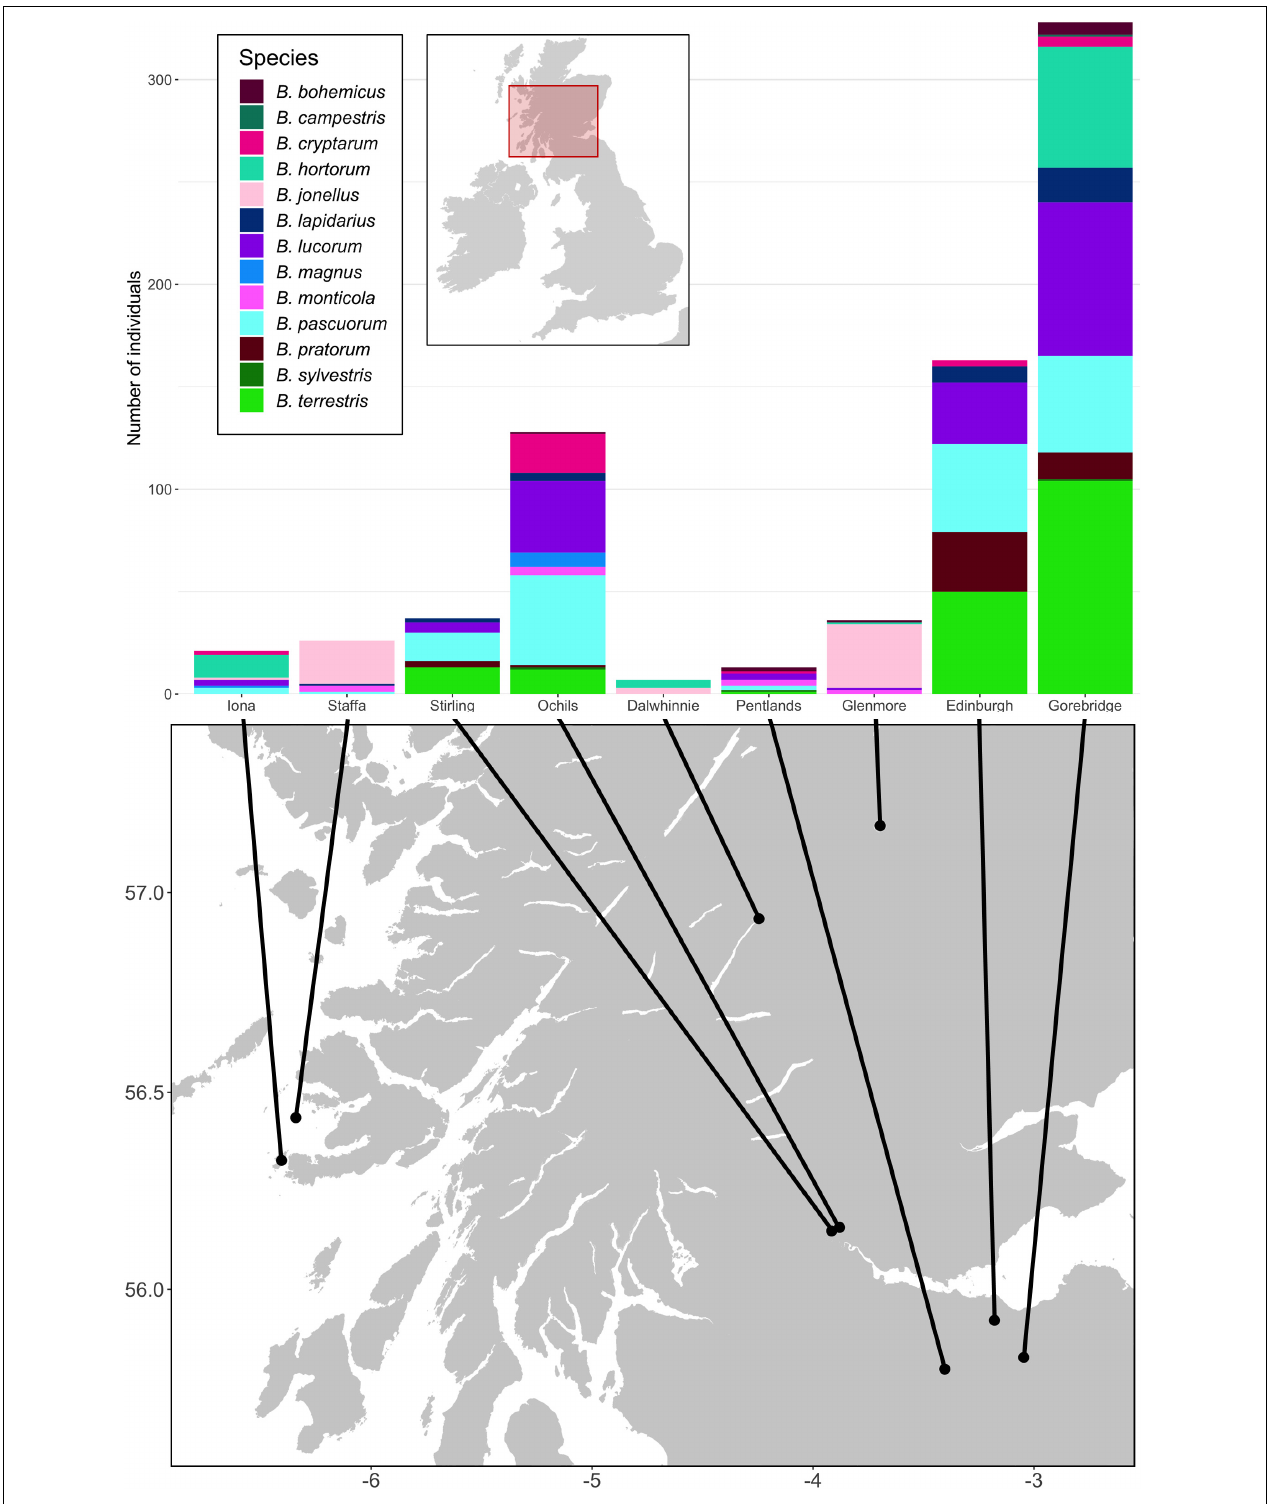
FIGURE 1 | The locations of the sampling sites and species distributions and sample sizes of the bumblebees caught at them. For each site, all bees taken from that site were sampled on the same day. The Ochil Hills, Glenmore, Dalwhinnie, Stirling, Iona, Staffa, and the Pentlands were sampled in 2009, while Edinburgh and Gorebridge were sampled in 2011. Map adapted from tiles by Stamen Design, under Creative Commons (CC BY 3.0) using data by OpenStreetMap, under the Open Database License.